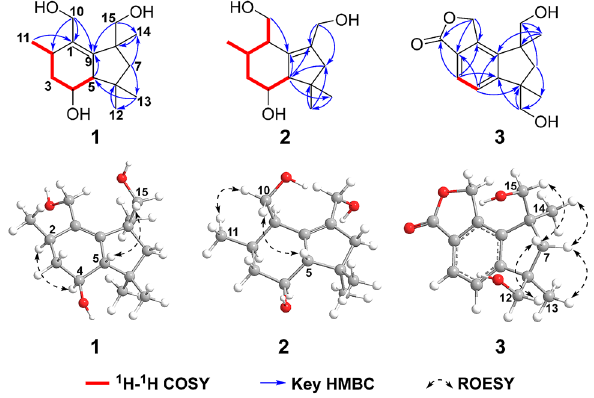
Fig. 2 Key 2D NMR correlations of compounds 1 –